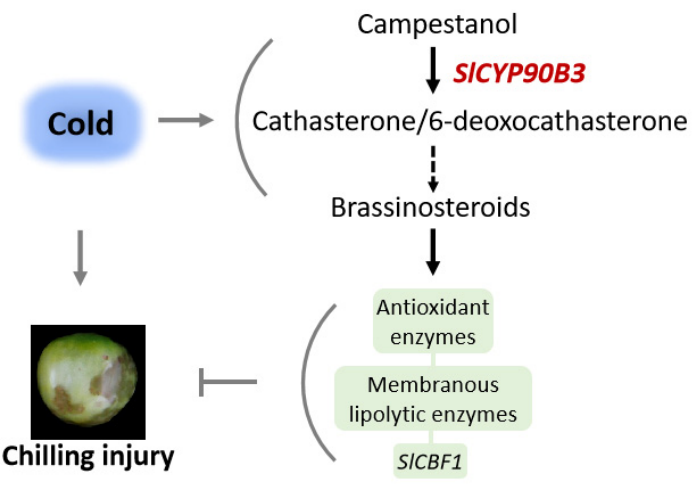
Figure 6. A proposed model of the involvement of the BR biosynthetic gene SlCYP90B3 in the alleviation of chilling injury of tomato fruits during cold storage. Low temperature promoted the expression of BR biosynthetic genes in tomato fruits. The overexpression of the BR biosynthetic gene, SlCYP90B3 , alleviated chilling injury and enhanced chilling tolerance by promoting the activities of antioxidant enzymes including APX, CAT, POD, and SOD, suppressing the activities of LOX and PLD, as well as upregulating the expression of SlCBF1